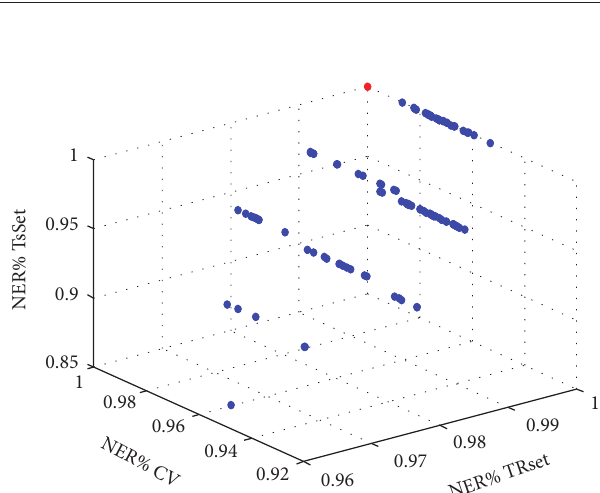
Figure 6: Results for the 100 models calculated. 𝑥 -axis: NER% calculated on the training set; 𝑦 -axis: NER% calculated in cross- validation; 𝑧 -axis: NER% calculated on the test set. The best theoretical model corresponding to a NER equal to 100% on the three axes is indicated in